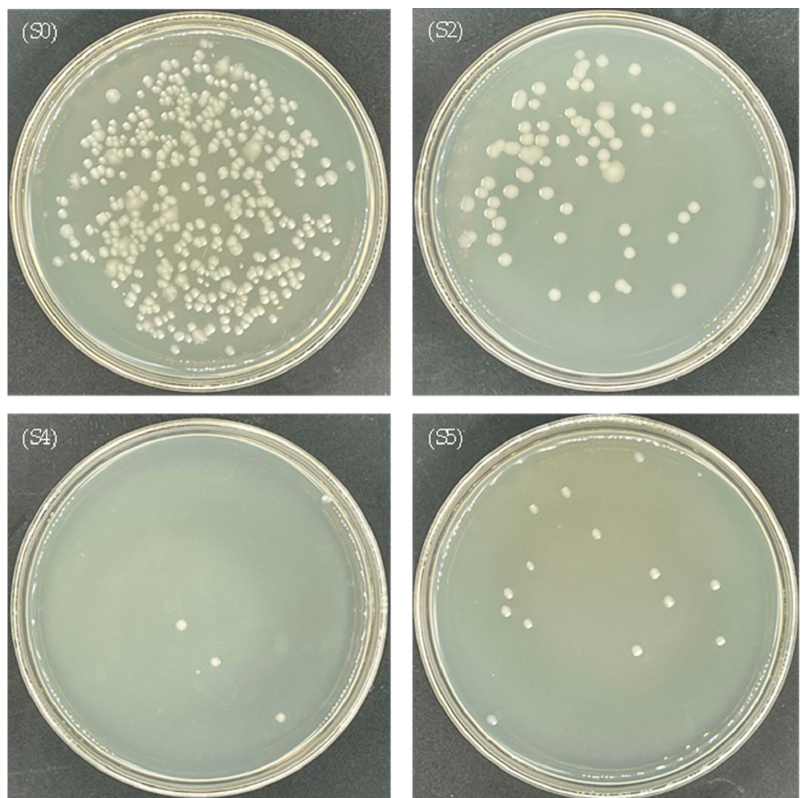
Figure 6. Photographs of the growth of E. coli on a petri-dish: (S0) control sample, (S2, S4, S5) experimental samples.